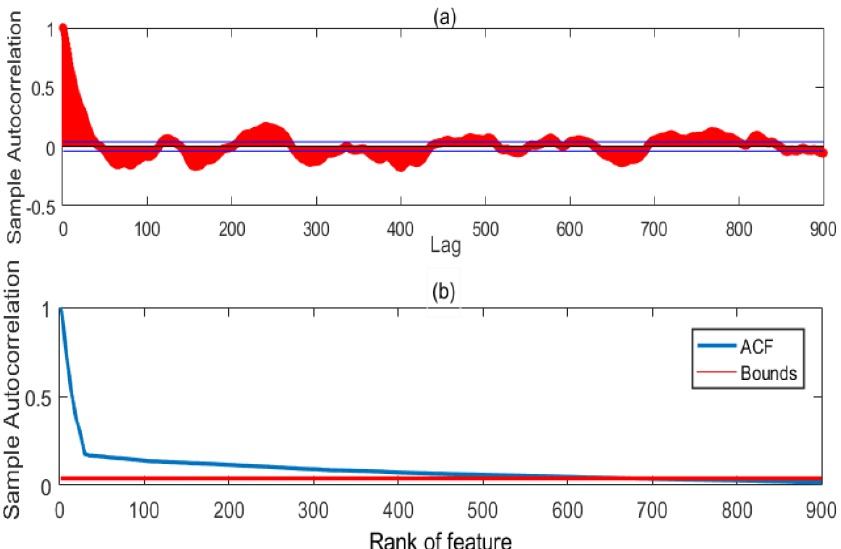
Figure 4. ACF of time lag variables and ranked ACF result in Beijing. ( a ): ACF for each time lag variable;( b ): ranked ACF. The closer the value is to 1, the greater the autocorrelation. Conversely, the closer the value is to 0, the smaller the